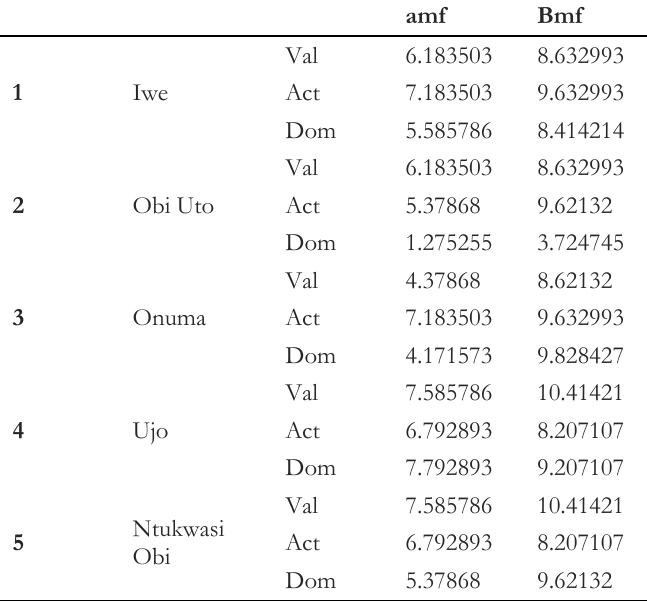
Table 12. Embedded T1FS for each emotion characteristics.